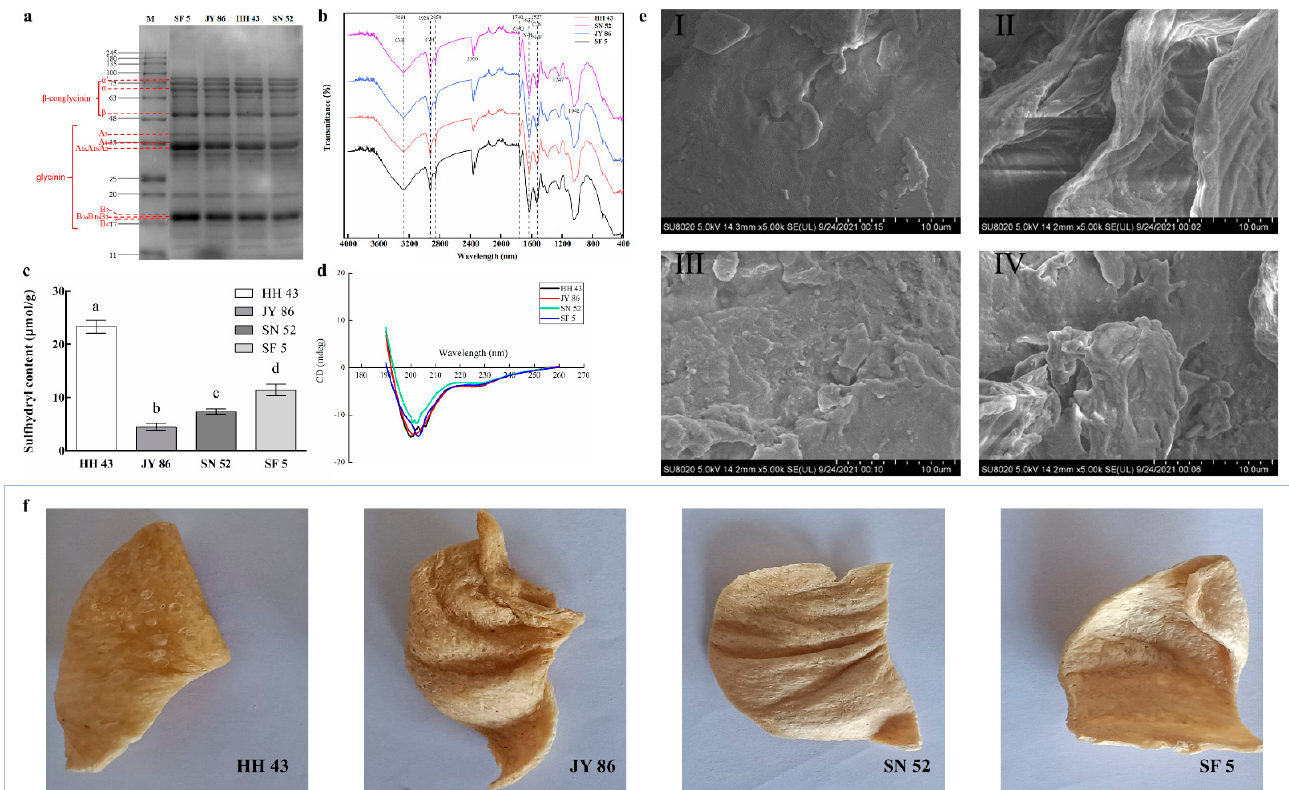
Different lowercase letters indicate a significant difference ( p < 0.05).